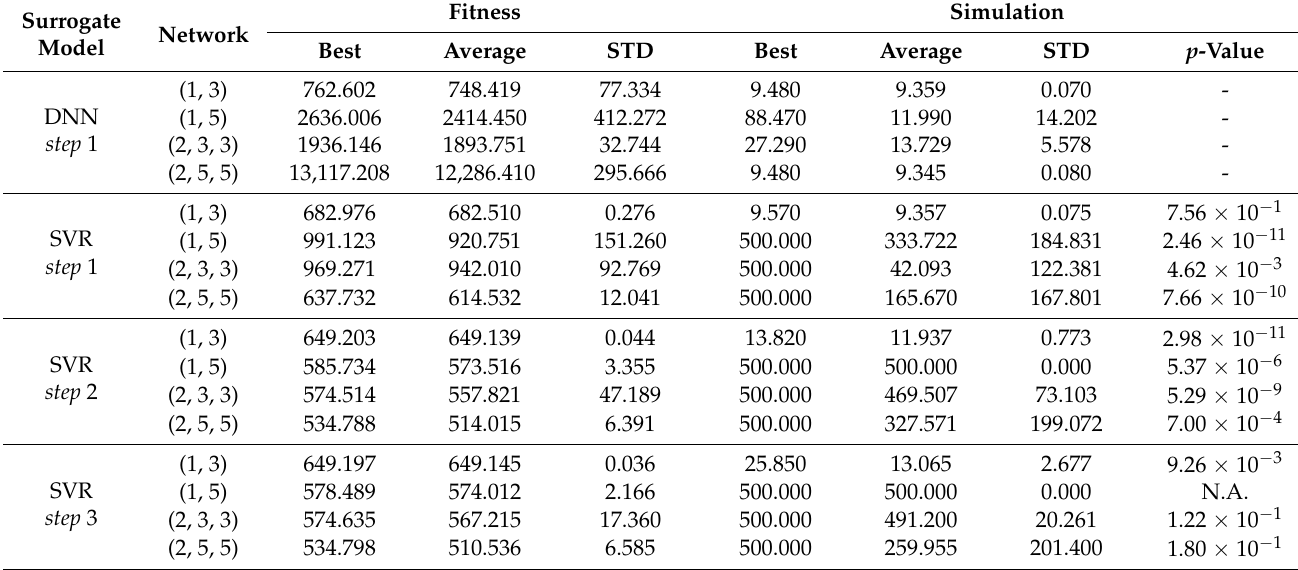
Table 5. Results of the SGAs for the cart-pole balancing problem according to the network architecture and surrogate model (from 30 runs).